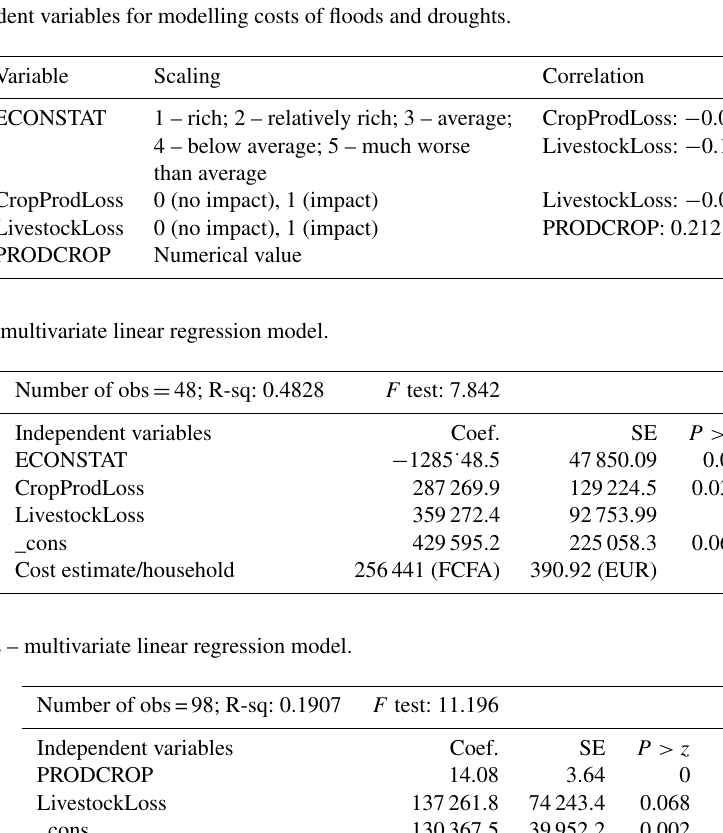
Table 10. Selected independent variables for modelling costs of floods and droughts.